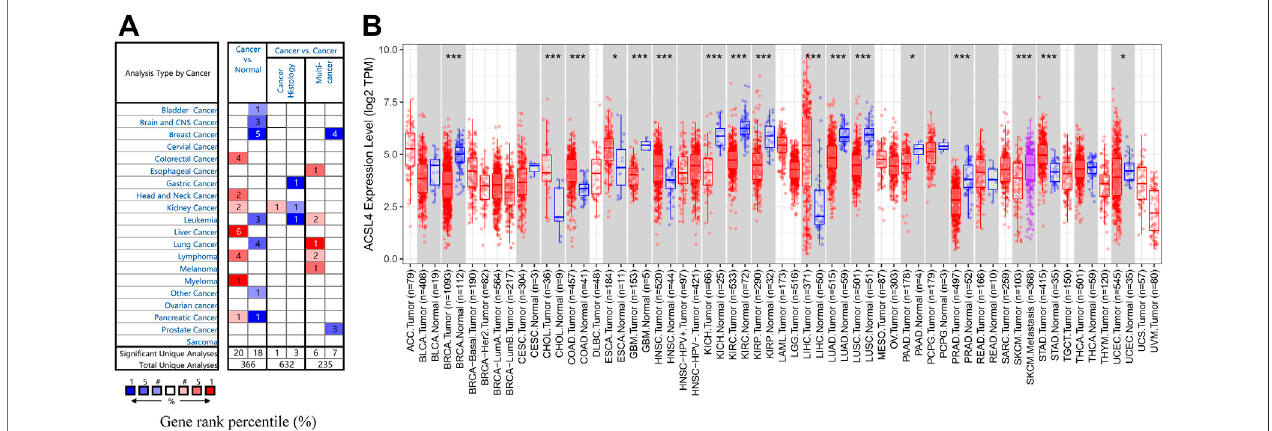
FIGURE1| mRNAExpressionLevelsofACSL4indifferentCancers. (A) .HighorlowexpressionofACSL4indifferenthumancancertissuescomparedwithnormal tissuesinOncominedatabase.Thenumberineachcellpresenttheamountofdatasets. (B) .ACSL4expressionlevelindifferentcancersorspeci fi ccancersubtypeswith corresponding normal tissues from the TCGA database in TIMER (* p < 0.05, ** p < 0.01, *** p < 0.001).